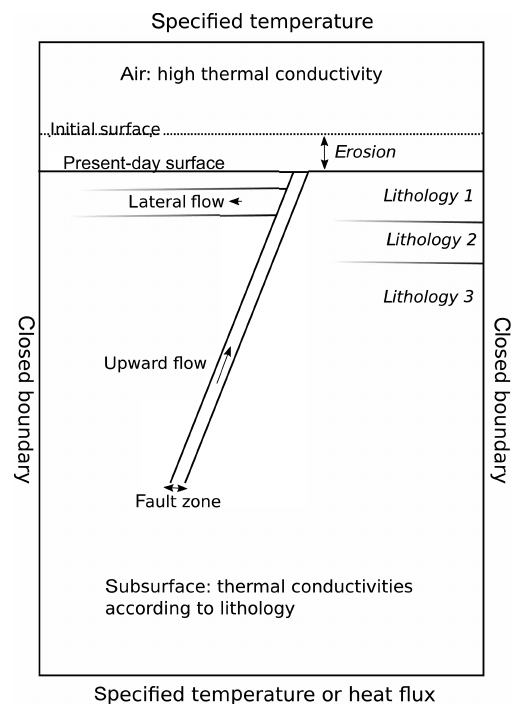
Figure 1. Conceptual model setup. The upper and lower boundary conditions were assigned a specified temperature according to the average annual air temperature and the regional geothermal gradi- ent. No heat flow is allowed over the left- and right-hand model boundary. Fluid flows upwards along a single fault zone, part of the flux contributes to lateral flow in one or more aquifers that are con- nected to the fault. The remaining fluid discharges at the surface. Heat transfer between the surface and the atmosphere is modelled as a conductive heat flow, with a variable thermal conductivity based on equations for sensible and latent heat flux. Heat transfer in the subsurface is determined by the specific thermal conductivities of the local lithologies. The land surface is lowered over time to ac- count for